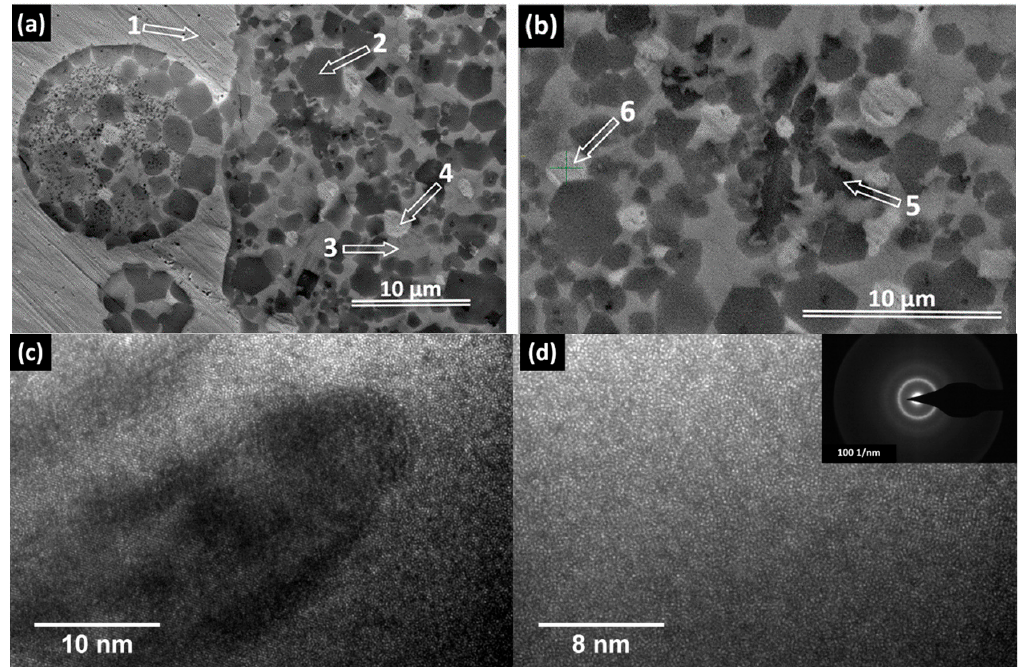
Figure 4. SEM and HR-TEM micrographs and position of characteristic zone for EDX analysis. ( a ) Transversal section trough 5 mm diameter rod, SEM; ( b ) Transversal section trough 2 mm diameter rod, SEM; ( c ) HR-TEM micrograph showing the interface between the amorphous zone (3) and an adjacent crystalline area; ( d ) HR-TEM micrographs, showing in detail only the amorphous area. The inset represent the corresponding selected area diffraction pattern (SAED). Table 1. Atomic compositions of labelled zones in Figure 4.